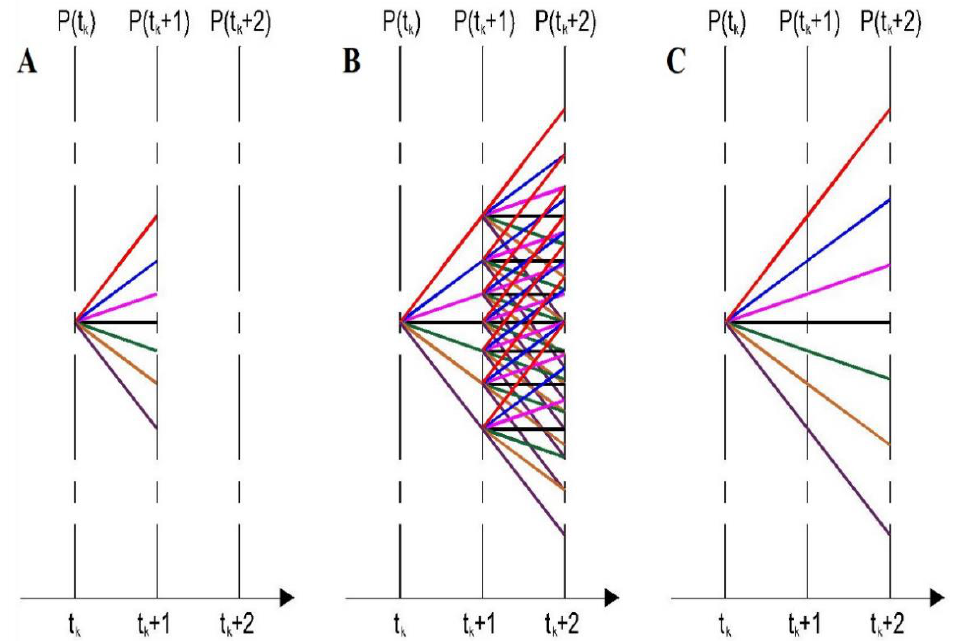
Figure 6. Representation of the Forecast scheme, ( A ) for horizon N = 1, ( B ) for horizon N = 2 taking the different vectors throughout sampling duration, and ( C ) N = 2 taking the similar vectors throughout the two sampling duration.